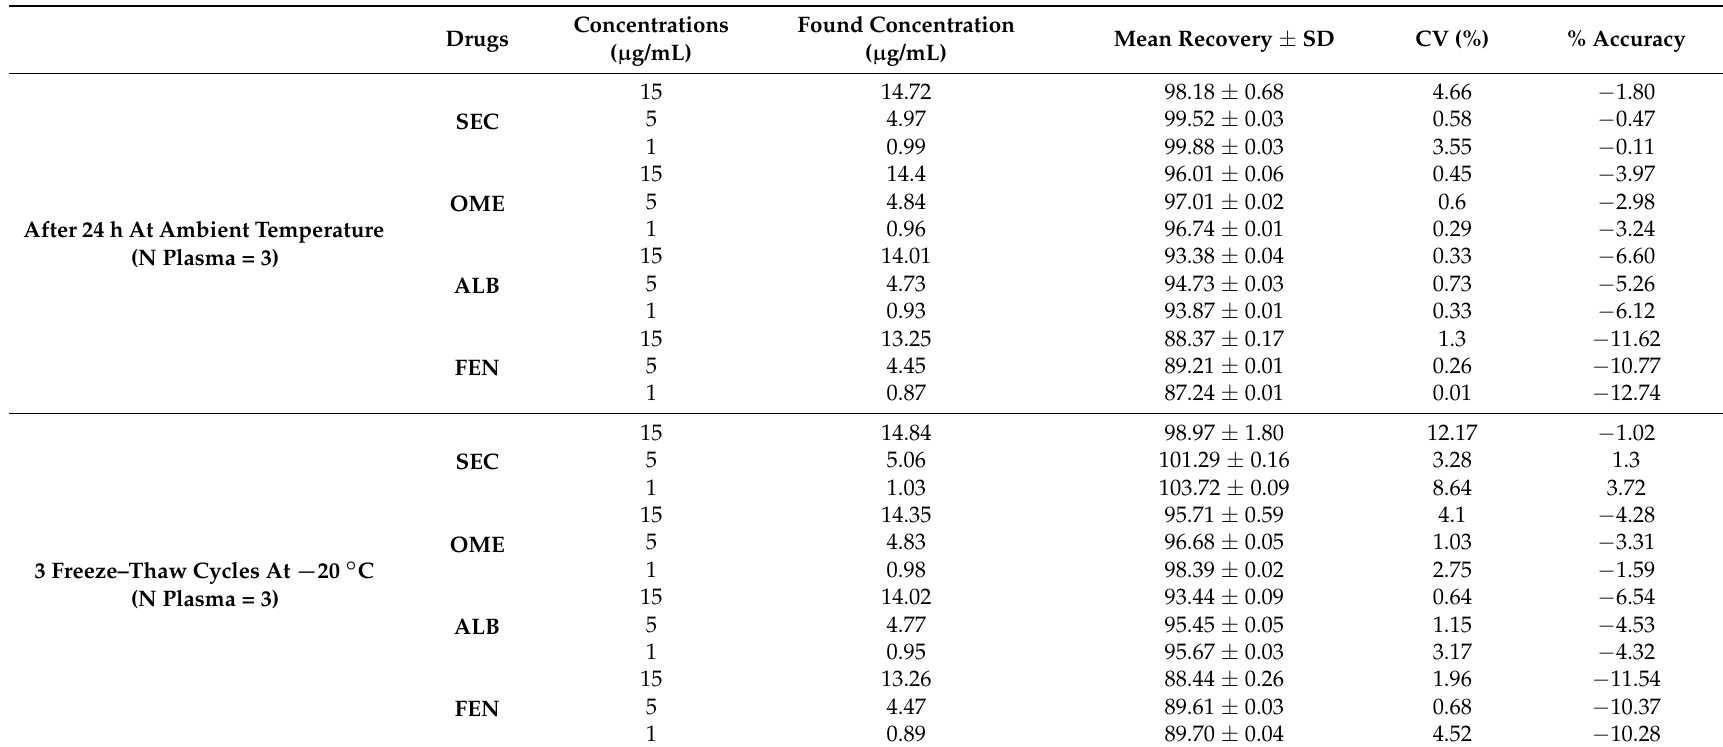
Table 9. Stability results of SEC, OME, ALB, and FEN in plasma samples using the proposed method. Concentrations Found Concentration Drugs Mean Recovery ± SD CV (%) % Accuracy ( µ g/mL) ( µ g/mL)